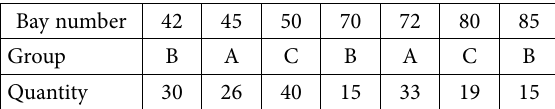
Fig. 2. Illustration of the YC and containers in a block of a yard Table 1. The work schedule of QC A